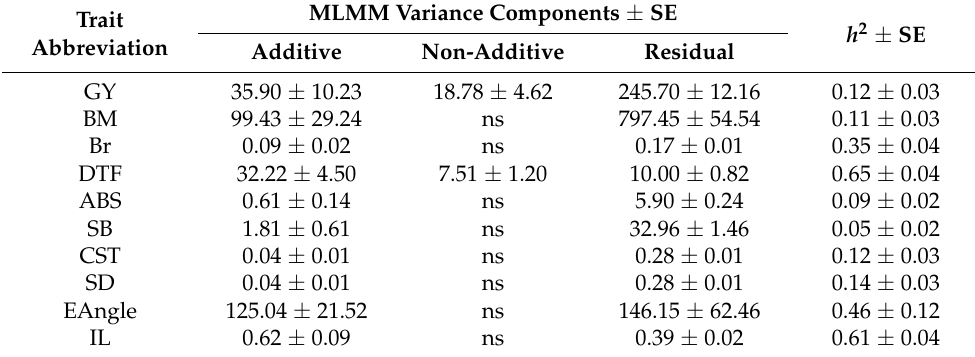
Table 2. Additive genetic, non-additive genetic, and residual variance components from the optimized multivariate linear mixed model (MLMM) analysis for 10 traits scored in Cycle 3 of the experimental field pea breeding population.